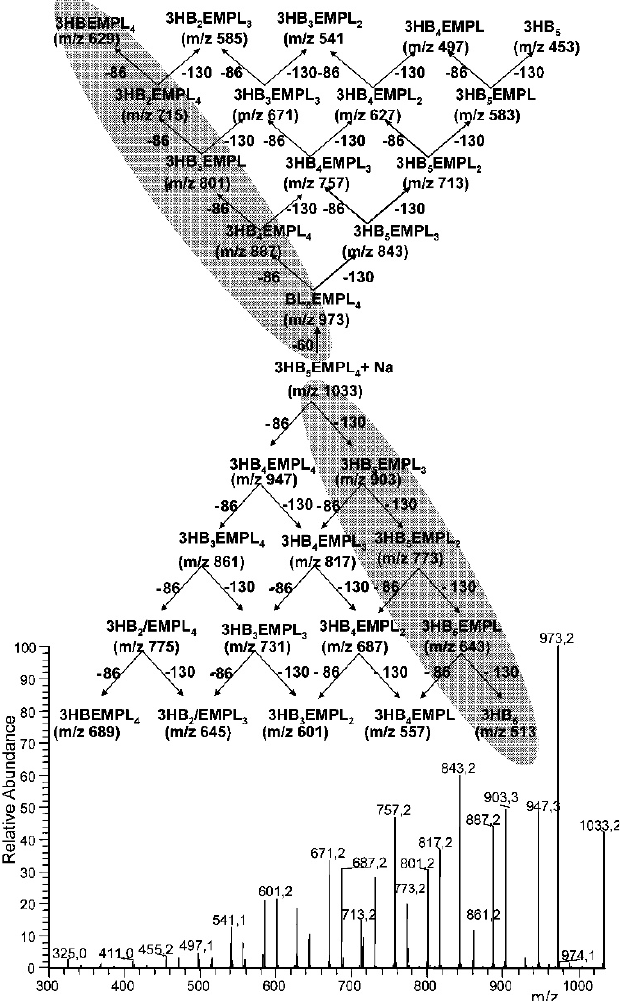
Figure 2. ESI-MS/MS spectrum of the sodiated precursor ion [3-HB 5 /EMPL 4 + Na] + , m/z 1033, selected from the simple ESI mass spectrum (series A) of a random copolyester sample. Theoretical fragmentation pathway of the selected ion. The part of the scheme indicated in gray shows the product ions formed from BBL- β -ethoxymethyl- β -propiolactone diblock copolyester molecular ions at m/z 1033. (Reprinted with permission from Ref. [33]. Copyright 2009, American Chemical Society).